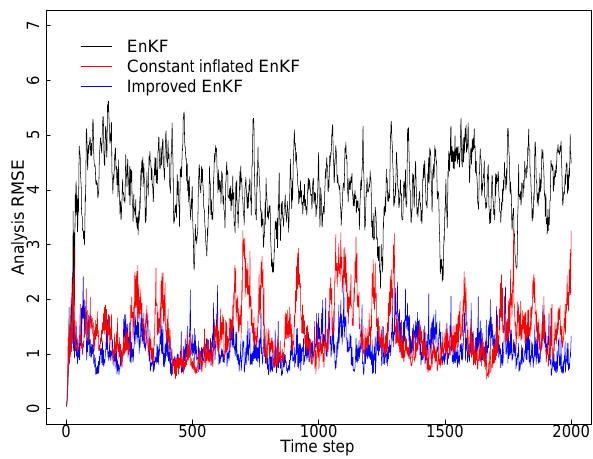
Figure 5. Analysis RMSE of the conventional EnKF (black line), the constant inflated EnKF (red line) and the improved EnKF (blue line) for the Lorenz-96 experiment with 40-observation and 30- ensemble member. The constant multiplicative inflation factor is set as 1.88.